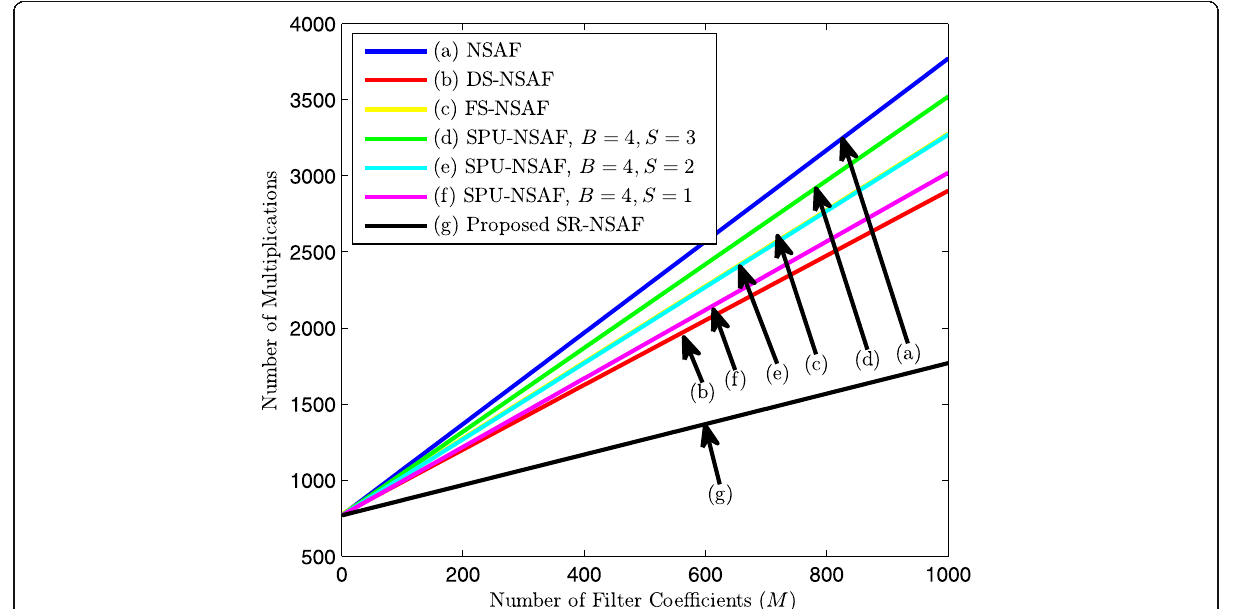
Fig. 2 Number of multiplications versus the filter length for NSAF, DS-NSAF, FS-NSAF, SPU-NSAF and proposed SR-NSAF with N = 8